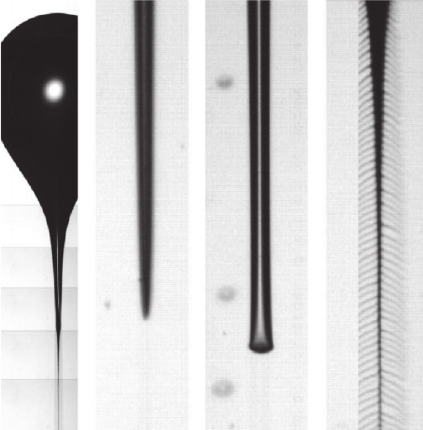
Figure 5: Shapes of bubble tails in a viscoelastic fluid, namely, associative polymer aqueous solution. From the left, the horseshoe crab tail, knife-edge, axe, and fish backbone tail can be seen [32].